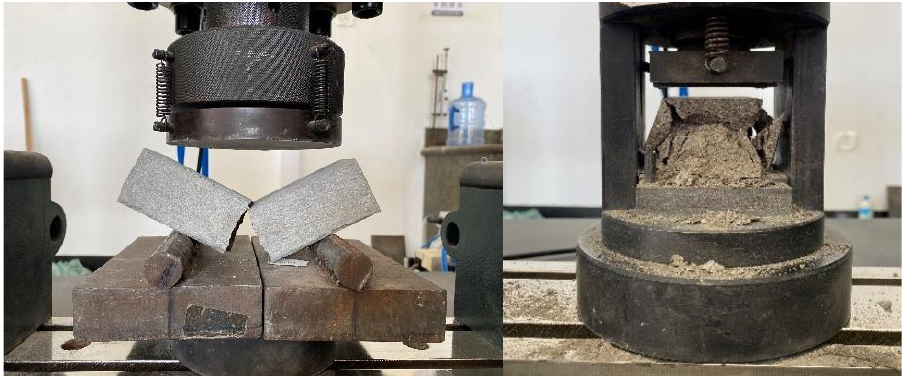
Figure 5. Diagram for bending and compression tests.